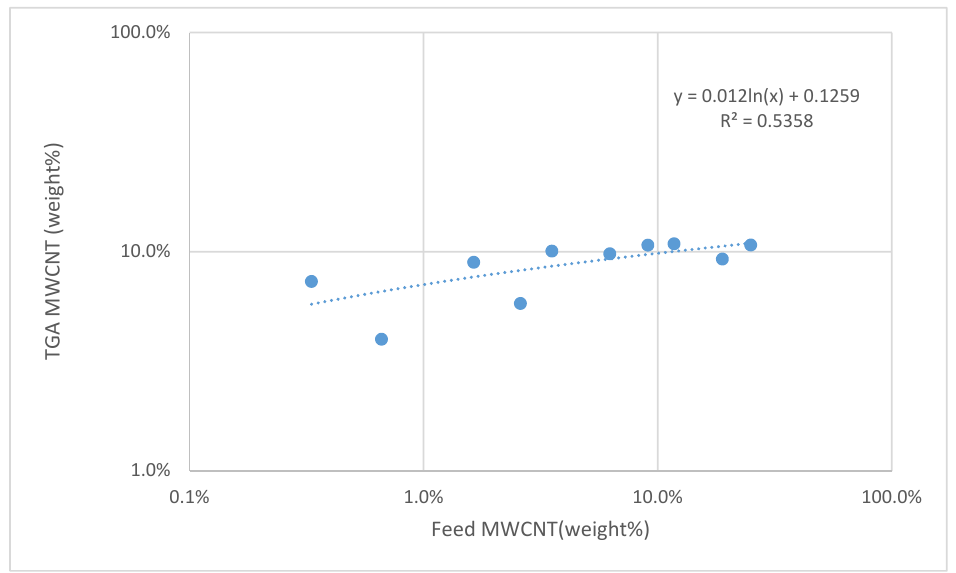
Figure 8. Plot of MWCNT wt% in the feed versus MWCNT wt% as obtained by TGA and fit with a logarithmic curve.